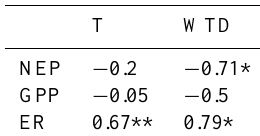
Table 3B. Spearman’s rank correlations between temperature, water table and NEP, GPP, and